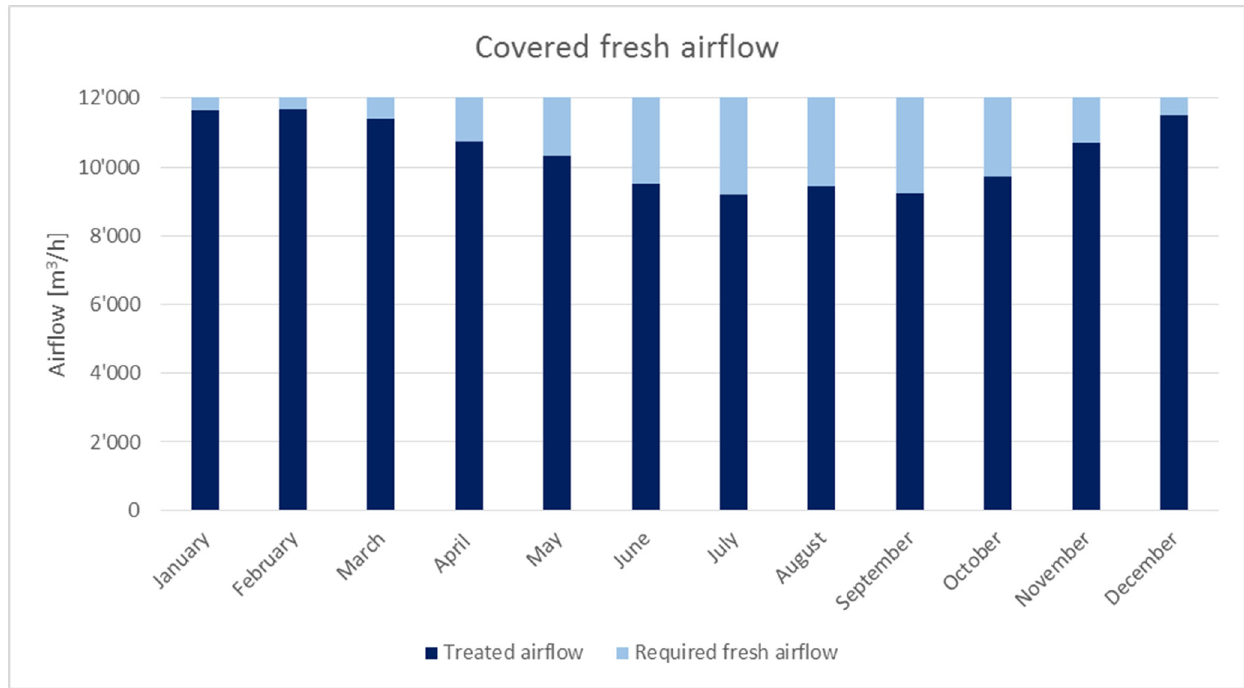
Figure 14. Comparison between the treated airflow, available and required fresh airflow.